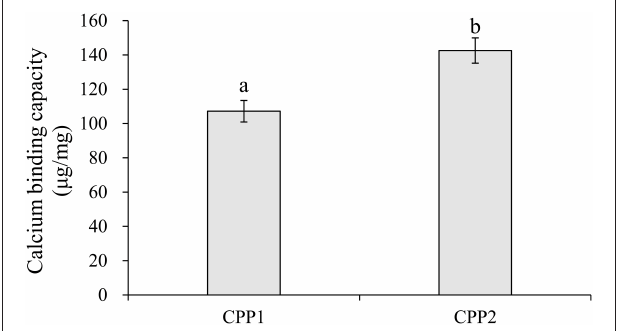
FIGURE 3 | Quantity of calcium transport across Caco-2 cell monolayers by CPP1 and CPP2. Different letters indicate statistical difference among the groups at the given time-point ( P < 0.05).